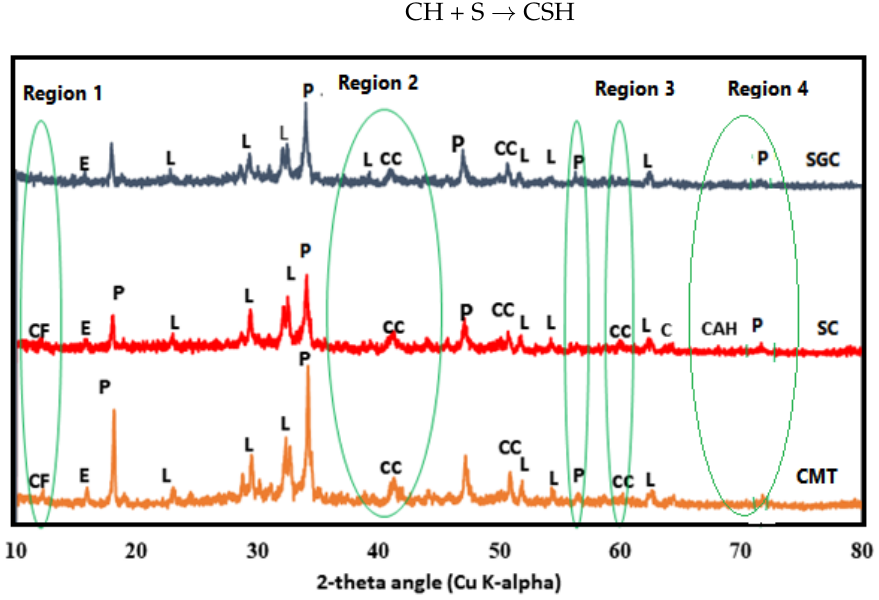
Figure 11. X-ray diffractogram of glass-blended silica-fume